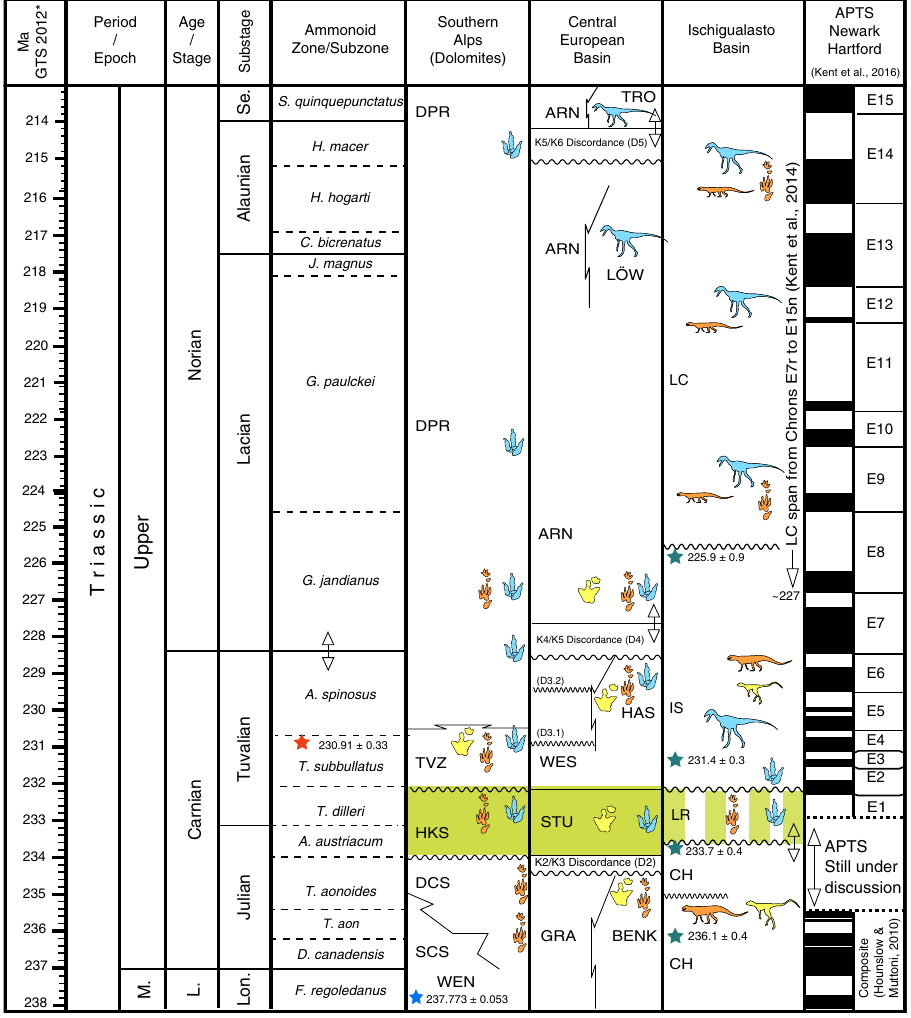
Fig. 3 Correlation between the earliest dinosaur occurrences across Pangaea. Note the synchronicity of the fi rst dinosaur diversi fi cation event during and after the CPE (light green boxes). Lithostratigraphic abbreviations. Dolomites: DCS: Cassian Dolomite; DPR: Dolomia Principale; HKS: Heiligkreuz Formation; SCS: San Cassiano Formation; TVZ: Travenanzes Formation; WEN: Wengen Formation. CEB (Central European Basin): ARN: Arnstadt Formation; BENK: Benk Formation; GRA: Grabfeld Formation; LÖV: Löwenstein Formation; STU: Stuttgart Formation; TRO: Trossingen Formation; WES: Weser Formation. Ischigualasto Basin: CH: Chañares Formation; IS: Ischigualasto Formation; LC: Los Colorados Formation; LS: Los Rastros Formation. Lithostratigraphy of CEB from Stratigraphische Tabellen von Deutschland 2016 (http://www.stratigraphie.de/std/Bilder/5_2.pdf). Red Star: Aglianico-Tuff, Lagonegro Basin 13 ; Blue Star: Rio Nigra Tuff, Dolomites 93 ; Green Star: Radiometric ages from Ischigualasto Basin (from Ezcurra et al. 9 and those published in ref. 6 ). Archosaur silhouettes: skeletal data; Footprint silhouettes: ichnological data; Light blue: dinosaurs; Yellow: non-dinosaurian dinosauromorphs; Orange: crurotarsans. Fossil occurrences from refs. 4, 6, 9, 25, 29, 32, 65 – 73, 76 – 78, 80 . Ages as in Fig. 1. The silhouette images were created by the authors